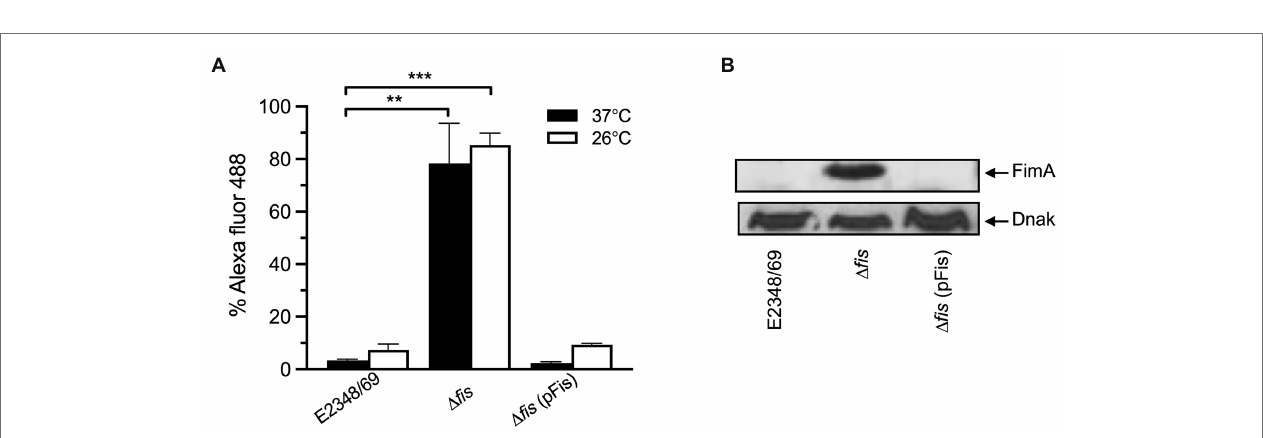
FIGURE 3 | Complementation of E2348/69 Δ fis with fis on a plasmid restores negative regulation. (A) Flow cytometry and (B) Western blot to determine production of T1P by wild-type E2348/69, E2348/69 Δ fis mutant, and E2348/69 Δ fis complemented with fis on pUC19. These data are the mean of at least three experiments performed in triplicate on different days. ** p < 0.01; *** p <